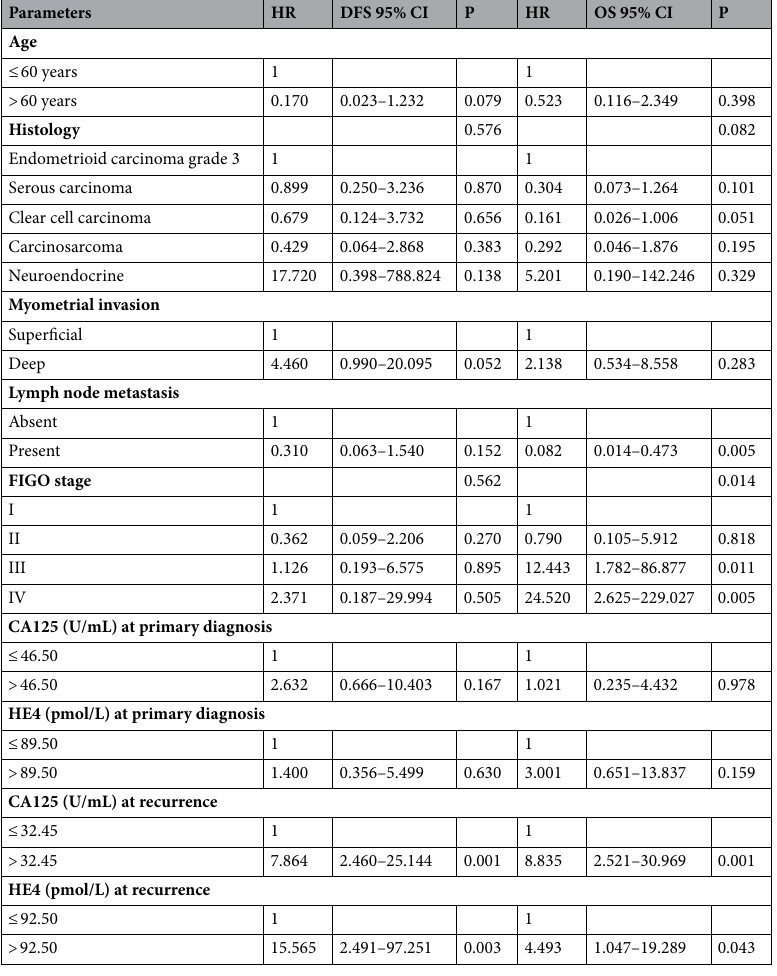
Table 5. Multivariate prognostic analyses. The total number of events were both 21 for recurrence and death. HR hazard ratio, CI confidence